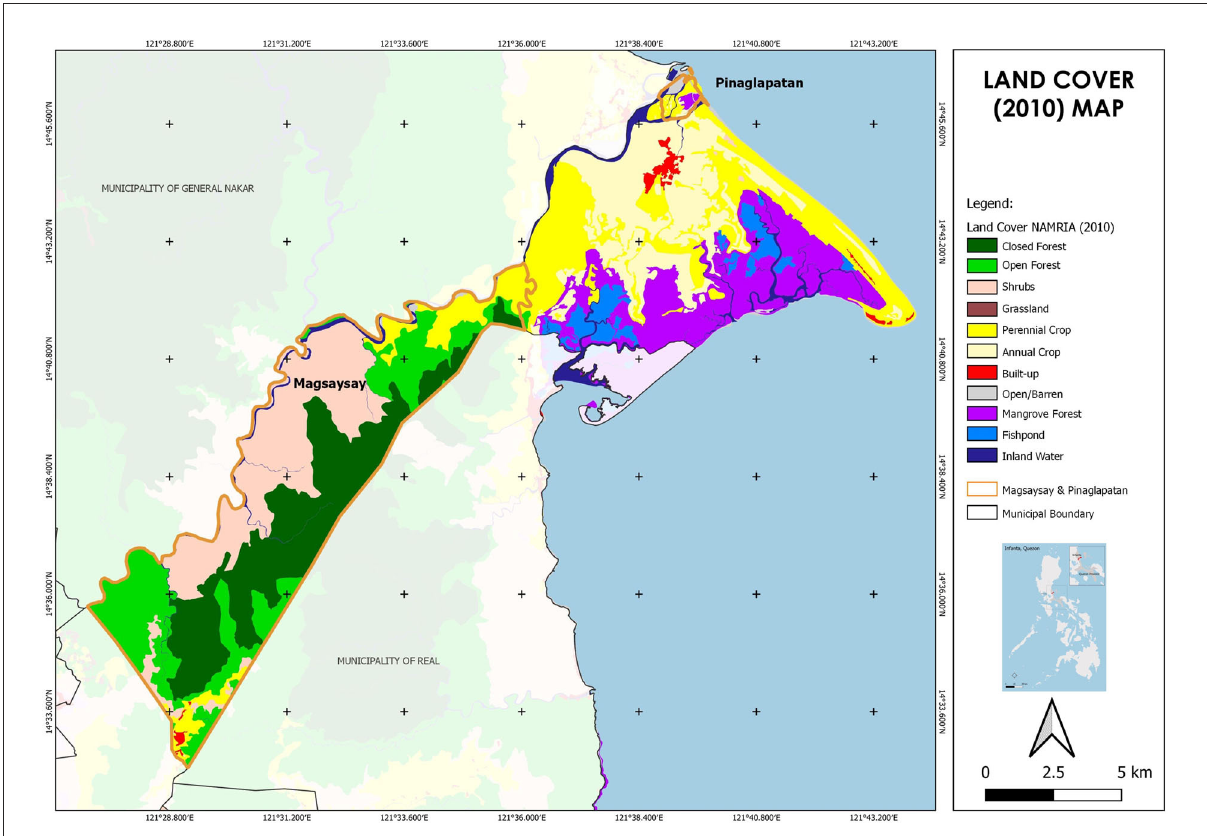
FIGURE2 Land cover map of Infanta in 2010. Source: Data from National Mapping and Resource Information Authority (NAMRIA).